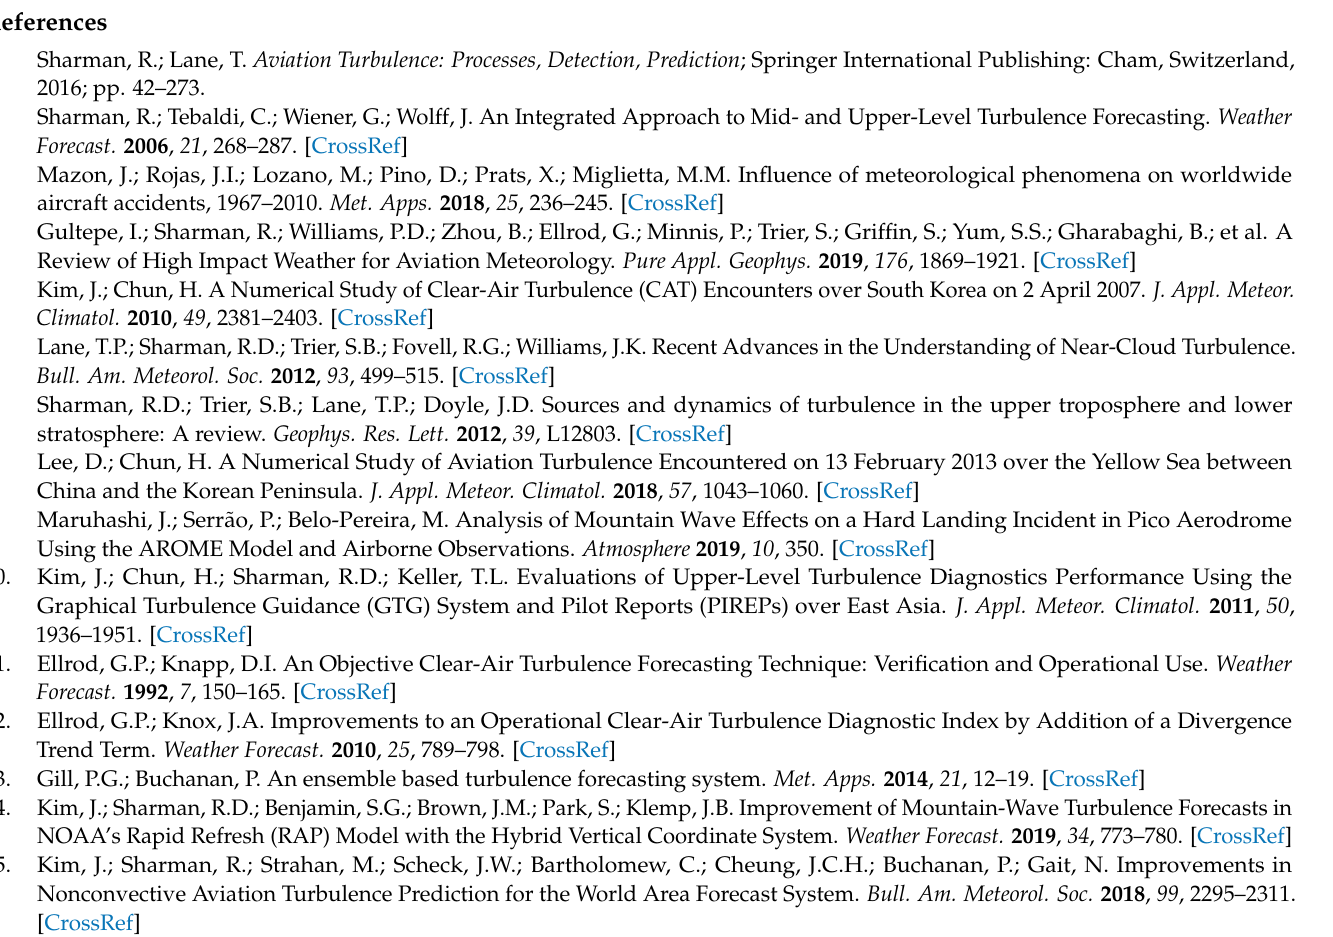
with T denoting air temperature. Richardson Number The Richardson number ( R i ) is a non-dimensional number, with the numerator rep- resenting the stratification and the denominator representing the vertical wind